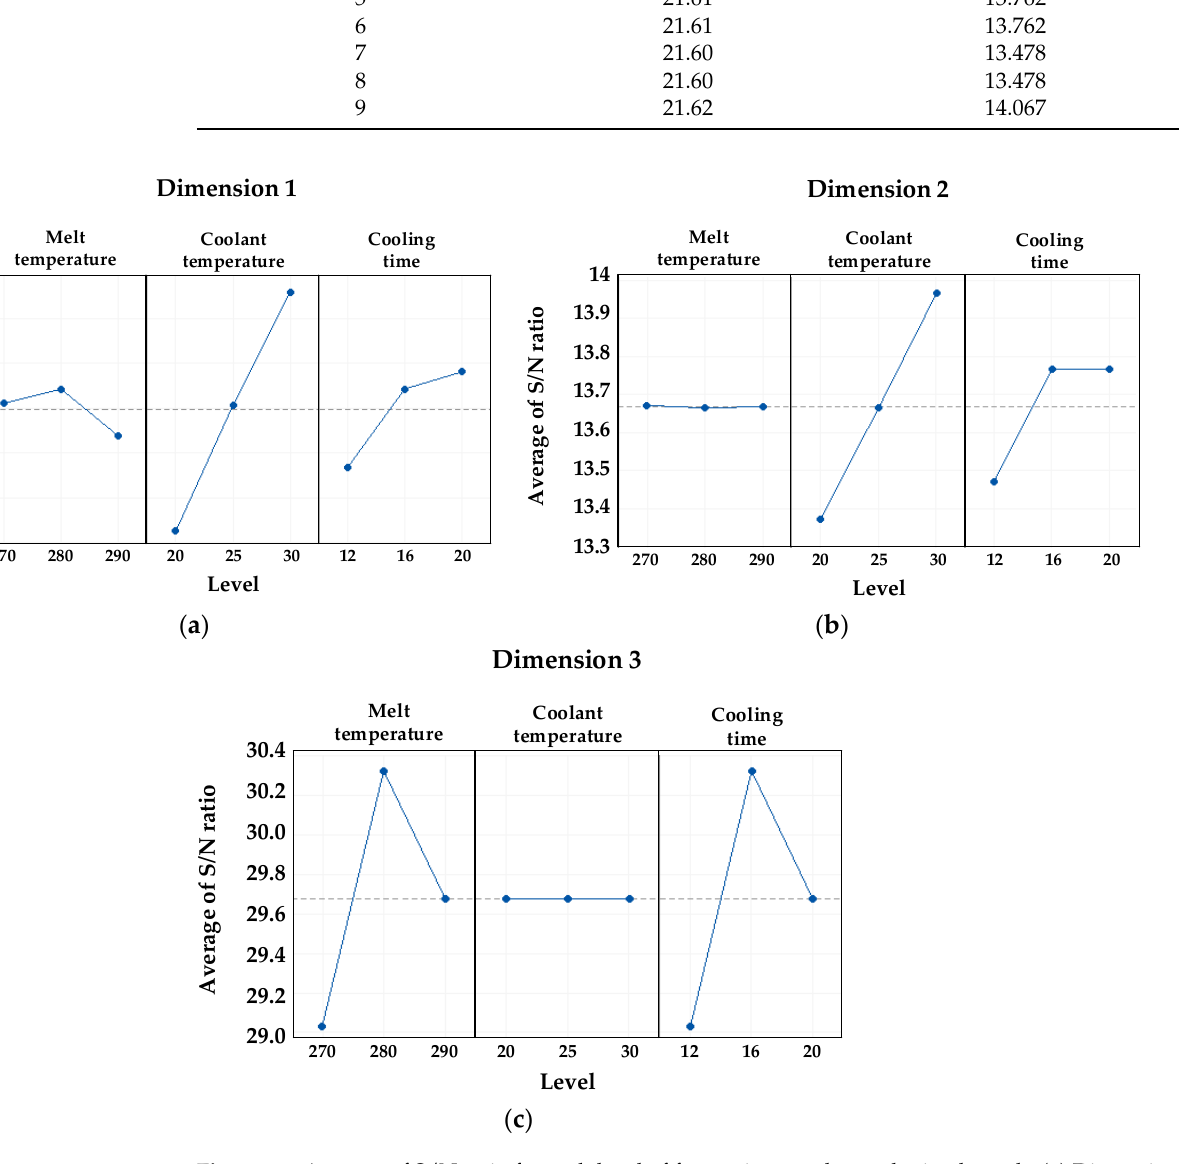
Figure 11. Average of S/N ratio for each level of factors in open-lever-obtained graph. ( a ) Dimension 1 ( b ) Dimension 2 ( c ) Dimension 3. Table 20. Average of S/N ratio for each level of factors in open lever.